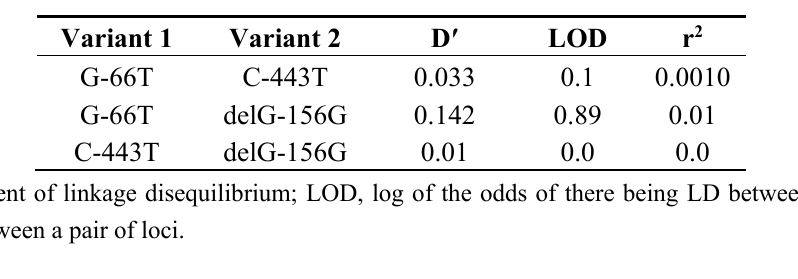
Table 5. A pair-wise comparisons of the polymorphisms, depicting the linkage disequilibria (LD)